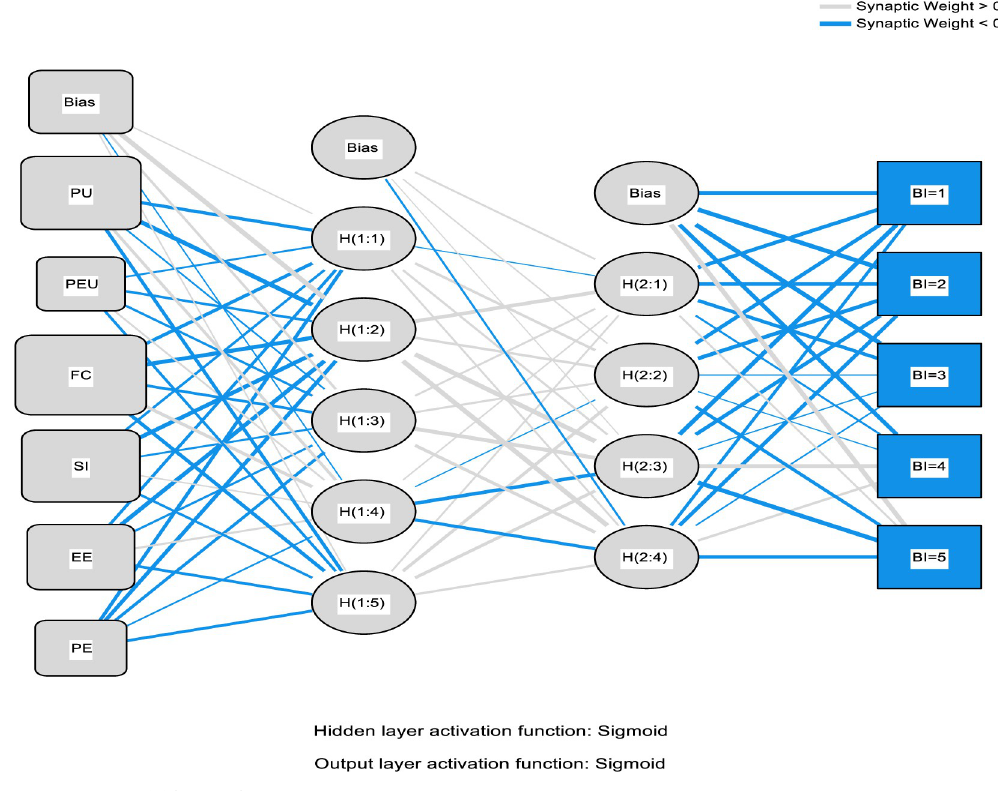
Fig 5. ANN model (Part III).